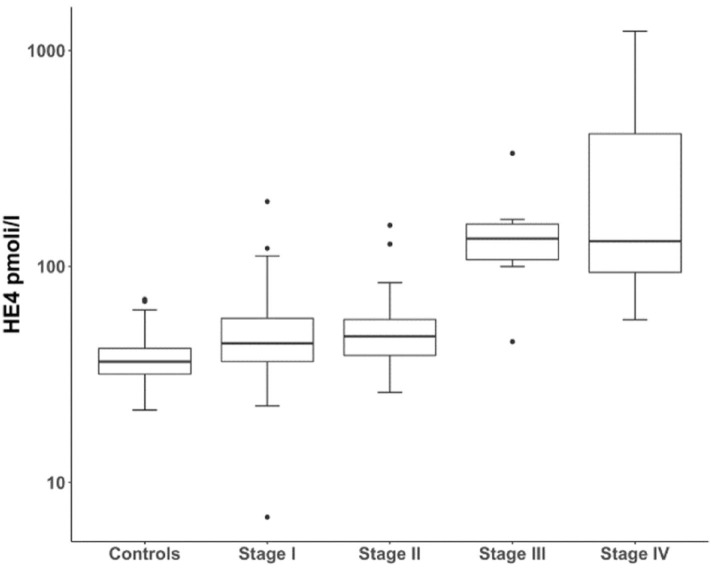
Boxplots of sHE4 levels in normal controls and UCC patients, according to FIGO stage.